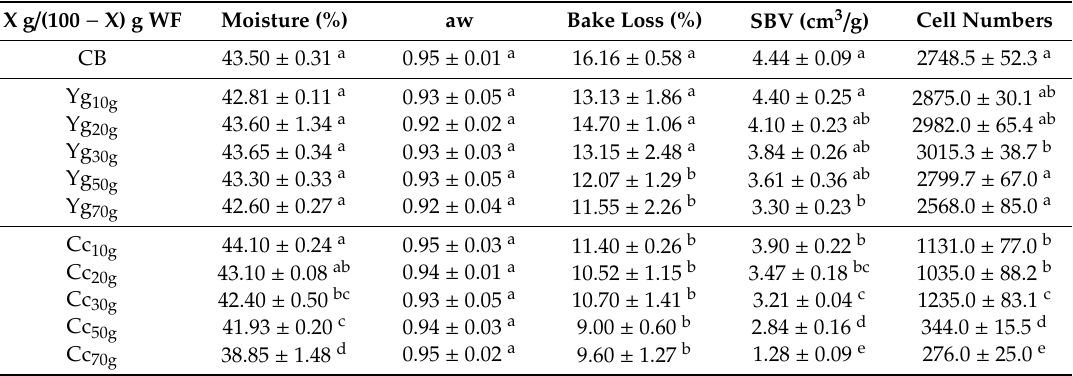
Table 3. Quality parameters, moisture, aw, bake loss, specific bread volume (SBV), and cell numbers of the control bread (CB—0 g / 100 g) and breads produced with yoghurt (Yg) and curd cheese (Cc) addition *.